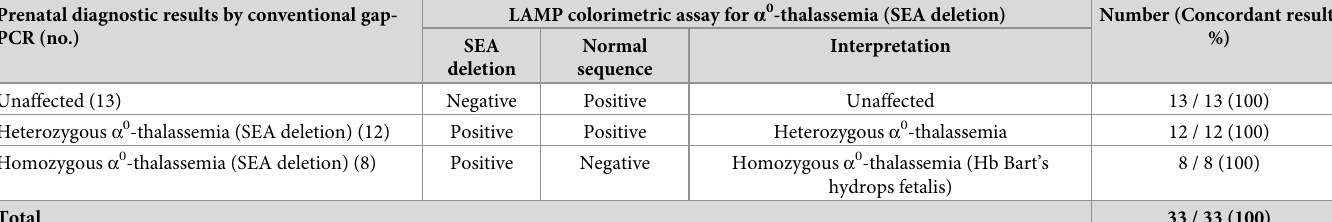
Table 3. Prenatal diagnosis of 33 fetuses at risk of having Hb Bart’s hydrops fetalis syndrome caused by homozygous α 0 -thalassemia using the LAMP colorimetric assay for α 0 -thalassemia (SEA deletion) in comparison with a routine conventional gap-PCR. Prenatal diagnostic results by conventional gap- PCR